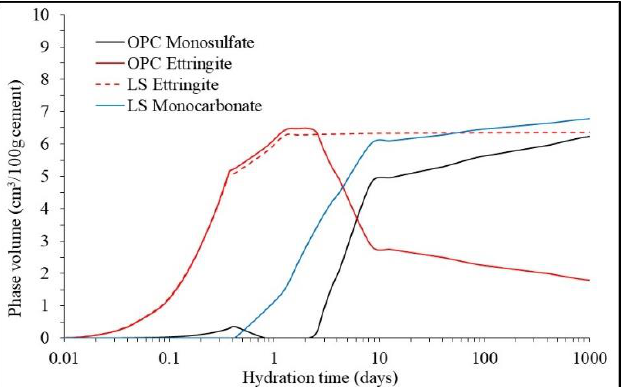
Figure 2. Phase assemblage produced by the PHREEQC model using [20] for the two cements. ( a ) OPC phase assemblage; ( b ) 4% limestone binder phase assemblage.